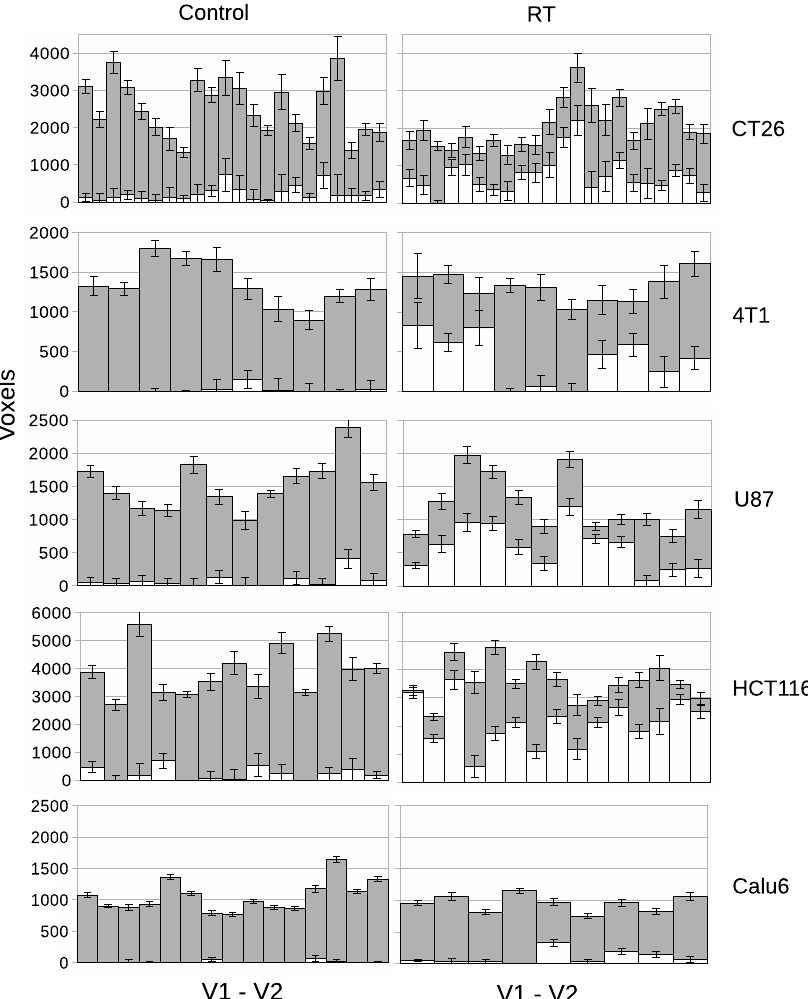
Figure 7. Per-tumor LPM assessment of treatment effects showing lower bound on affected tissue ( Q T ± σ ) in white and unaffected ( Q C ± σ ) in grey. Each bar represents a different tumor. The top plot confirms the null hypothesis of no treatment effects within the control cohort, followed by treatment cohorts showing responses. From left to right, control tumors and RT treated tumors. From top to bottom there are different tumor